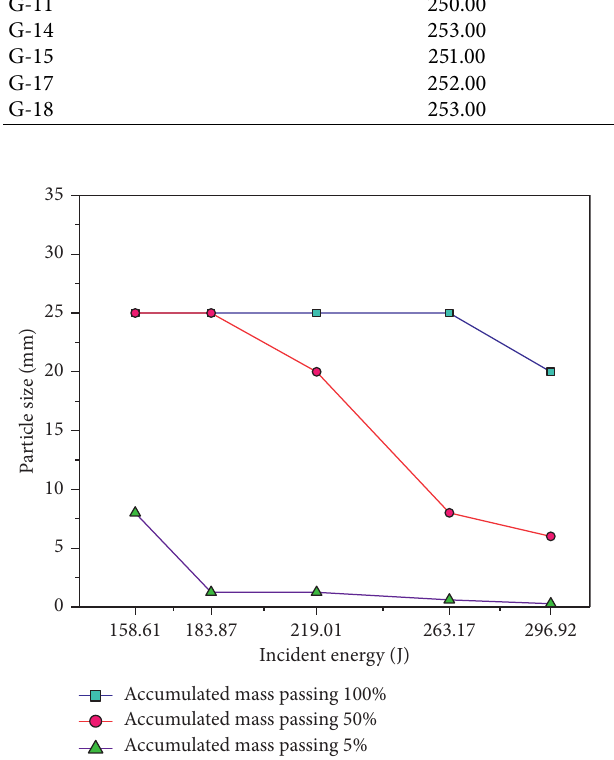
Figure 12: Particle size (mm) versus incident energy